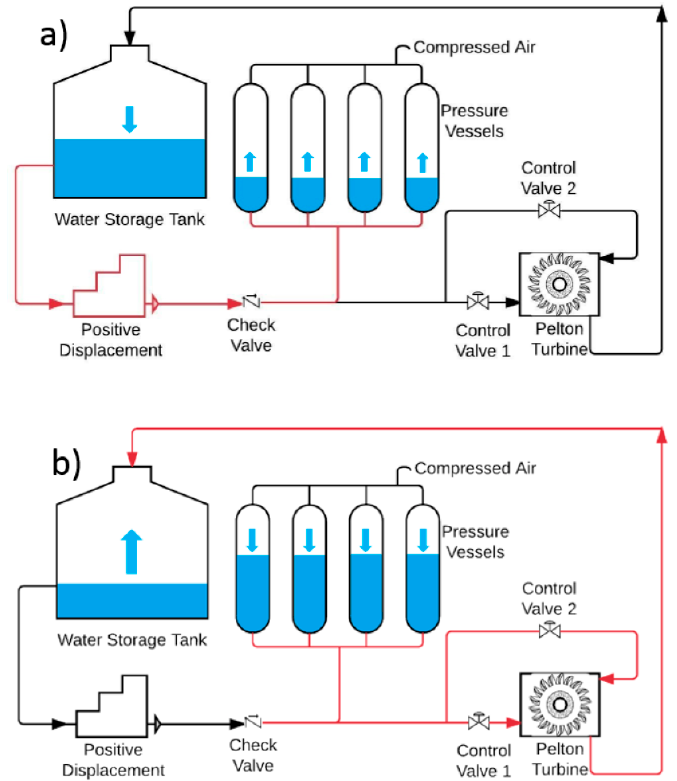
Figure 2. Simplest configuration of Ground-Level Integrated Diverse Energy Storage (GLIDES): ( a ) charging and ( b ) discharging.